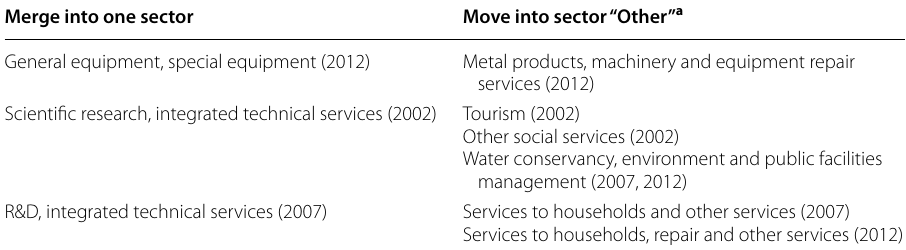
Table 9 Sector adjustment for province‑level IO table in